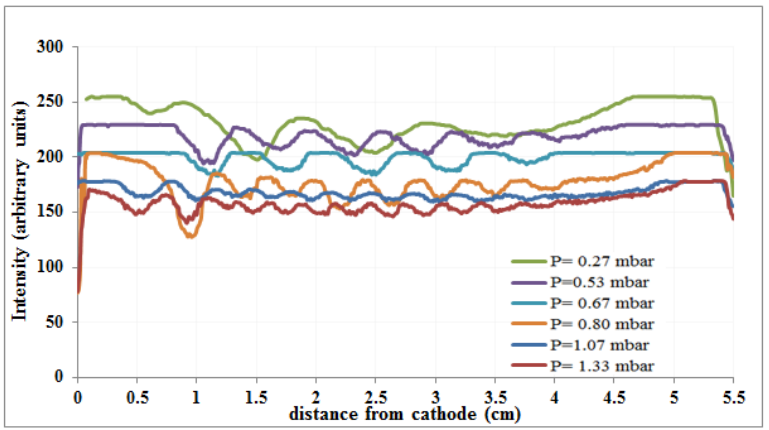
Fig. 6: Glow distribution on central line using the hollow cathode system at different working pressure, without magnetic field.